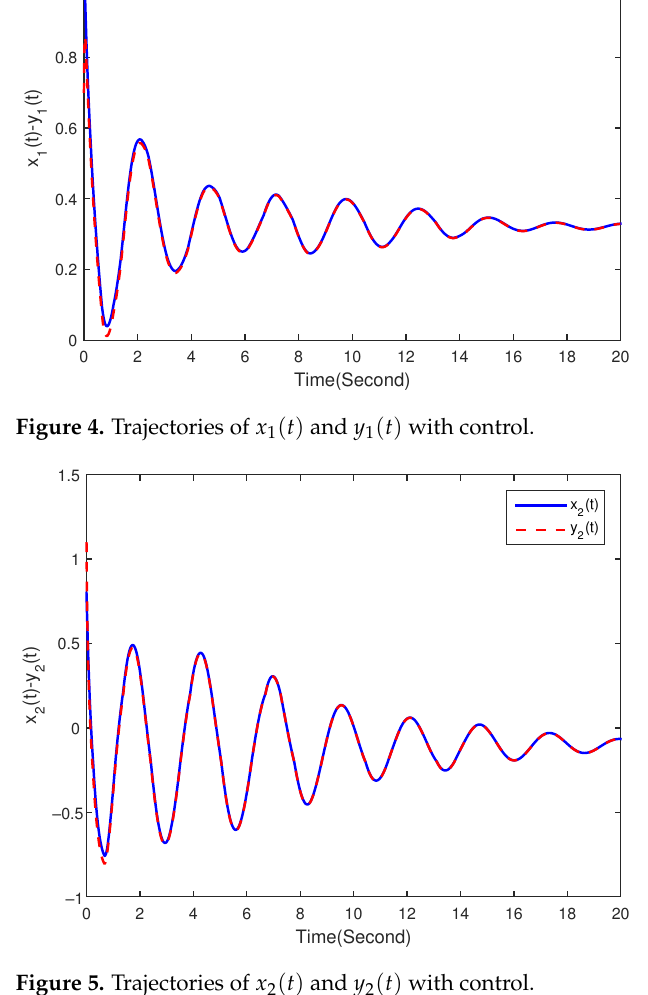
Figure 5. Trajectories of x 2 ( t ) and y 2 ( t ) with control.